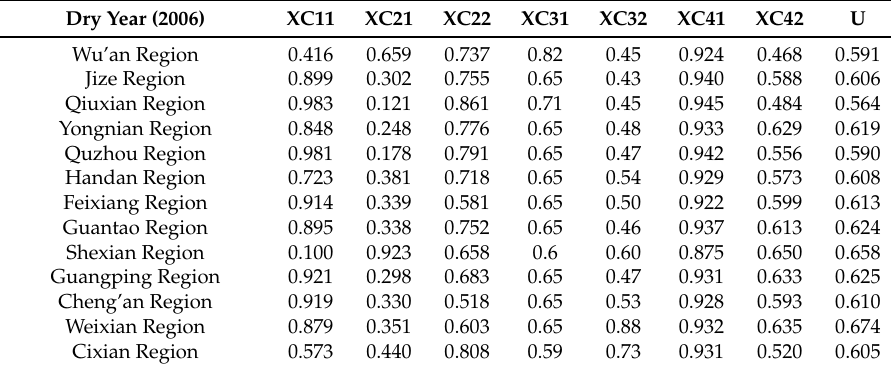
Table 9. Standard values of the second-class indices and the total SWA of different regions in the dry year